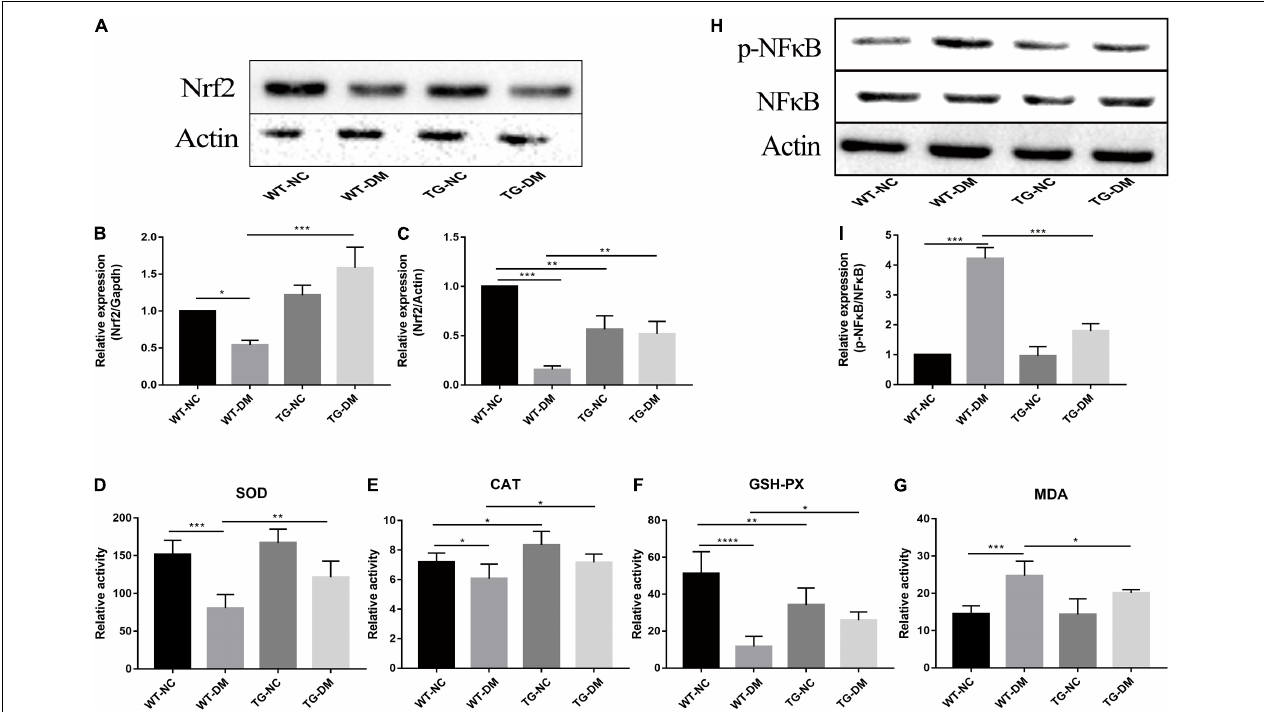
FIGURE 6 | Effects of Trx-1 on the gene and protein levels of Nrf2, the activation of NF κ B and antioxidant defense parameters. (A) Representative protein expression bands of Nrf2. (B) Real-time quantitative PCR of Nrf2 mRNA levels in mice hippocampal tissue. (C) Representative Western blot analysis of Nrf2. (D) Antioxidant defense parameter: SOD activity analysis. (E) Antioxidant defense parameter: CAT activity analysis. (F) Antioxidant defense parameter: GSH-PX activity analysis. (G) Antioxidant defense parameter: MDA activity analysis. (H) Representative bands of the expression of NF κ B. (I) Representative Western blot analysis of p-NF κ B/NF κ B. Tukey’s post hoc test for one-way ANOVA was used to analyze the mRNA levels, Western blot immunocontent, and antioxidant defense parameters. For each group, n = 6. The vertical lines represent the standard error of the mean. * p < 0.05, ** p < 0.01, *** p < 0.001, and **** p <